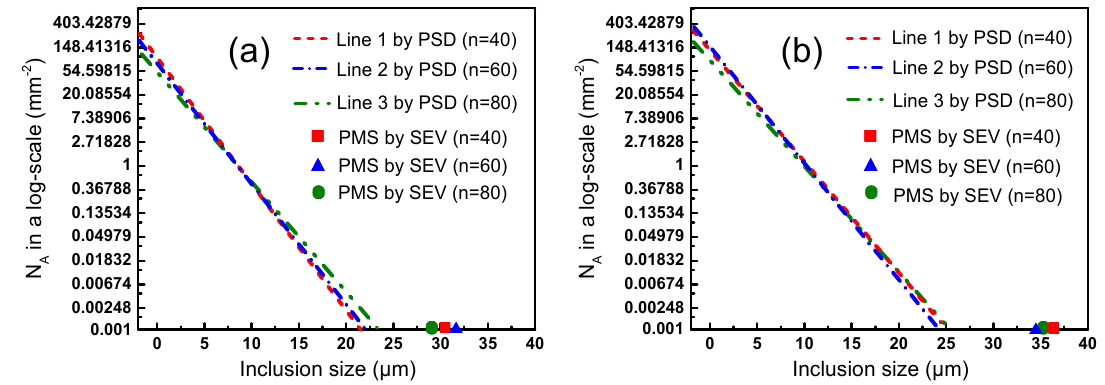
Figure 12. Comparison of regression lines by PSD (PMS by PSD noted as the intersection between line and X-axis) and PMS by SEV as a function of n ( = 40, 60 and 80) for ( a ) Steel A and ( b ) Steel B.